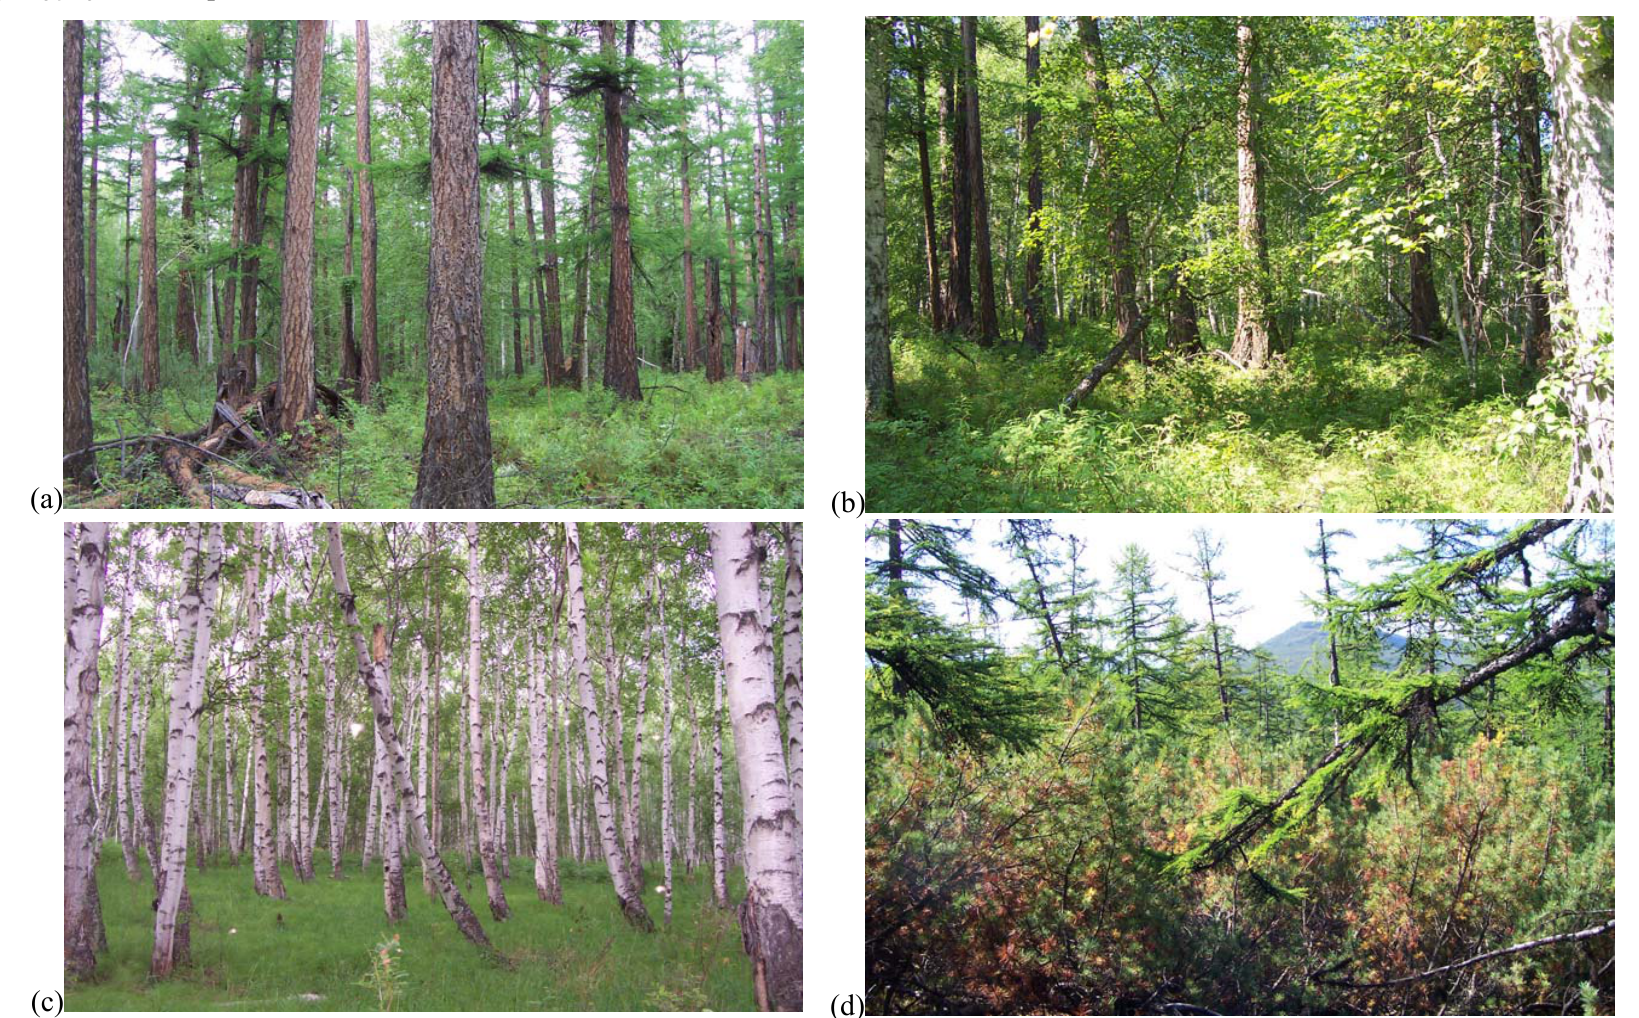
Figure 2. Photographs of forest plots, presented in same sequence as Table 1. (a,b) Lowland mixed Larix cajanderi – Betula platyphylla , (c) lowland B. platyphylla , (d,e) upland L. cajanderi with Pinus pumila sub-canopy, (f) upland mixed L. cajanderi – B. platyphylla , (g) upland B. platyphylla , (h) upland B. ermanii